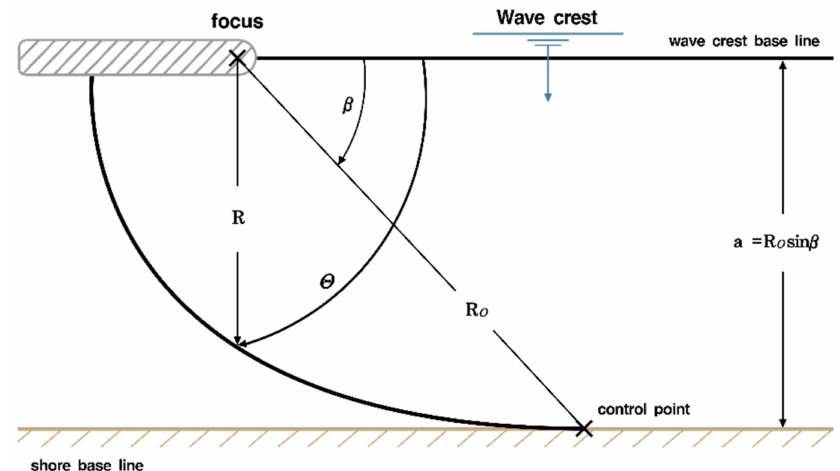
Figure 1. Definition sketch of parabolic model for bay-shaped beach.